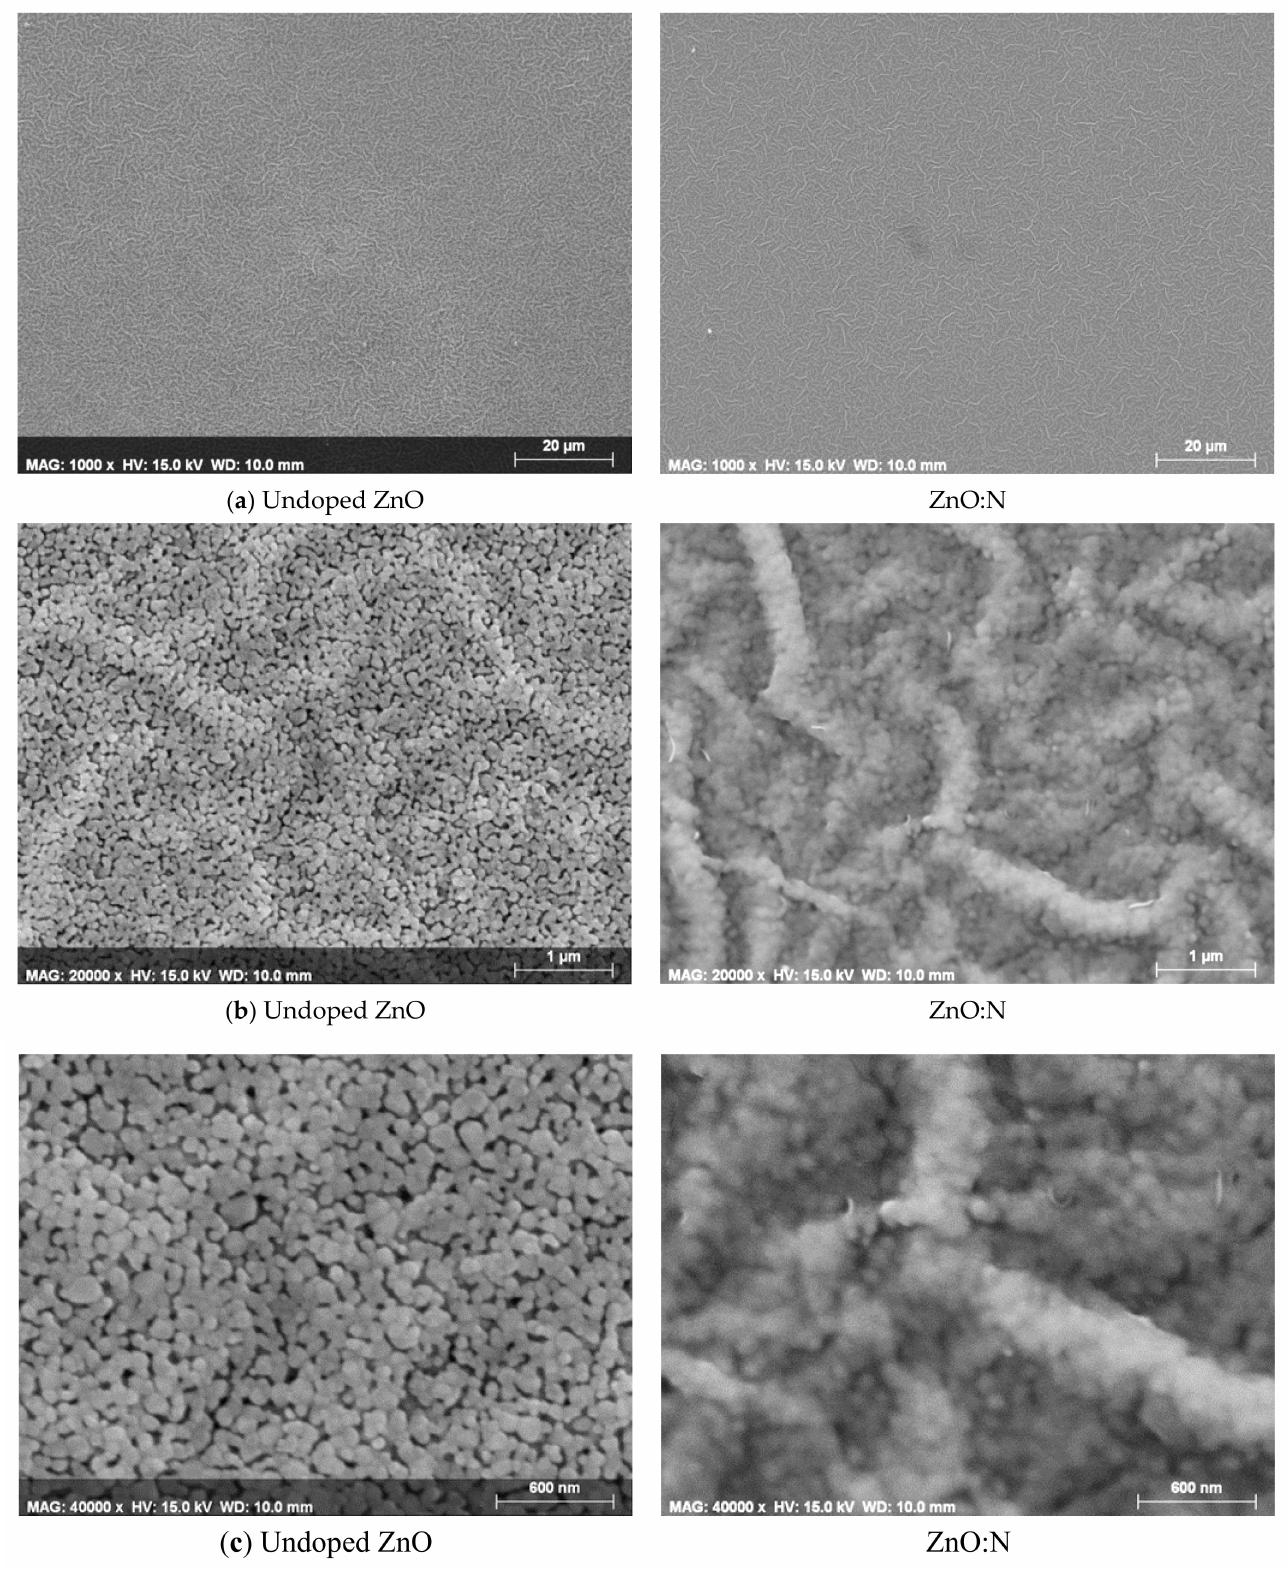
Figure 9. FESEM micrographs of ( a ) ZnO and ZnO:N films at magnification 1000, ( b ) ZnO and ZnO:N films at magnification 20,000 and ( c ) ZnO and ZnO:N films at magnification 40,000. The films are annealed at 600 ◦